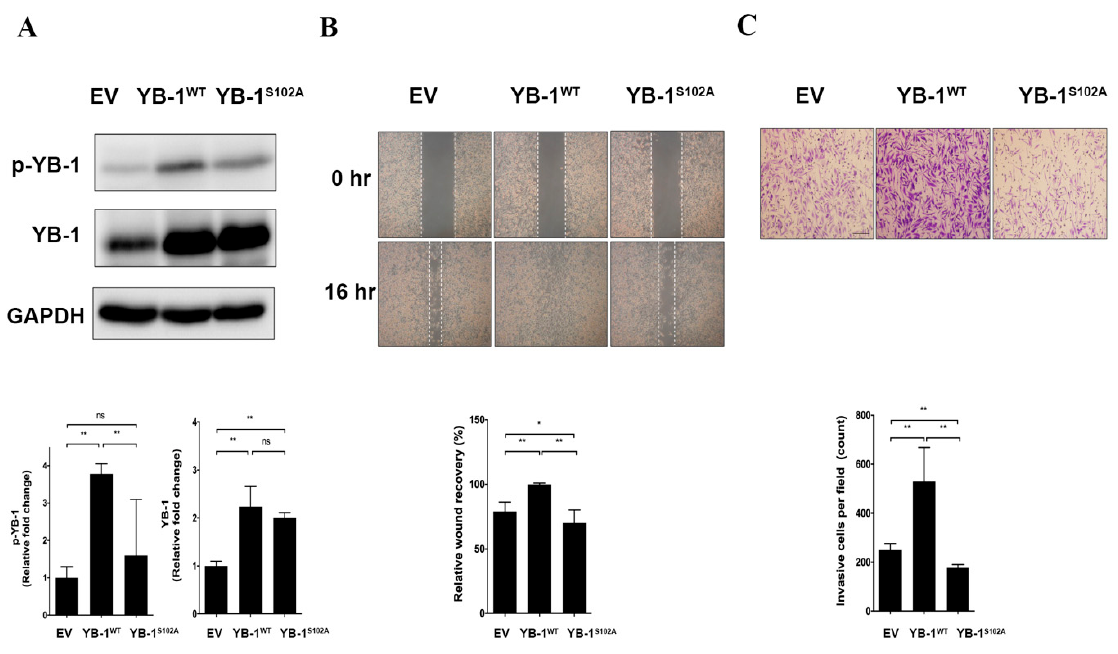
Figure 7. YB-1 S102 phosphorylation is required for migration and invasion of HuH-7 R cells. ( A ) HuH-7 R cells were infected with lentiviruses containing empty vector control (EV), YB-1 wild-type (YB-1 WT ) or YB-1 serine 102 to alanine mutant (YB-1 S102A ) and after 24 h, lysed and analyzed via immunoblotting with the indicated antibodies, upper panel. The relative expression efficiency of WT and S102A YB-1 was quantified using GAPDH as normalization control, lower panel. ( B ) Wound healing assay of EV, YB-1 WT or YB-1 S102A -overexpressing HuH-7 R cells. The micrographs depict cells that migrated into the gap 0 h and 16 h after removal of the insert, upper panel. Wound recovery was quantified, lower panel. ( C ) Transwell invasion assay of EV, YB-1 WT or YB-1 S102A - overexpressing HuH-7 R cells. Cells in the central field of each insert were visualized via light microscopy, upper panel. Invaded cells were quantified, lower panel. p values were determined using the t test (scale bar = 50 µ m; * p < 0.05; ** p < 0.01).